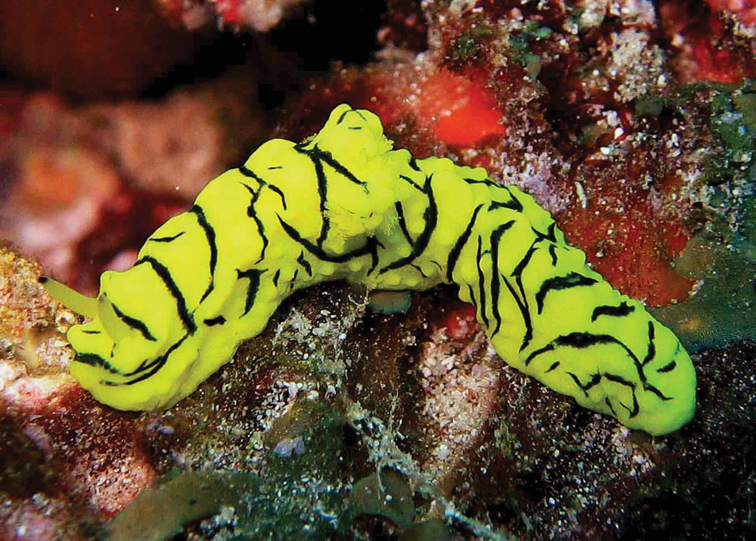
Notodoris minor, Pemba Island, photo: A de Villiers (no spcm).